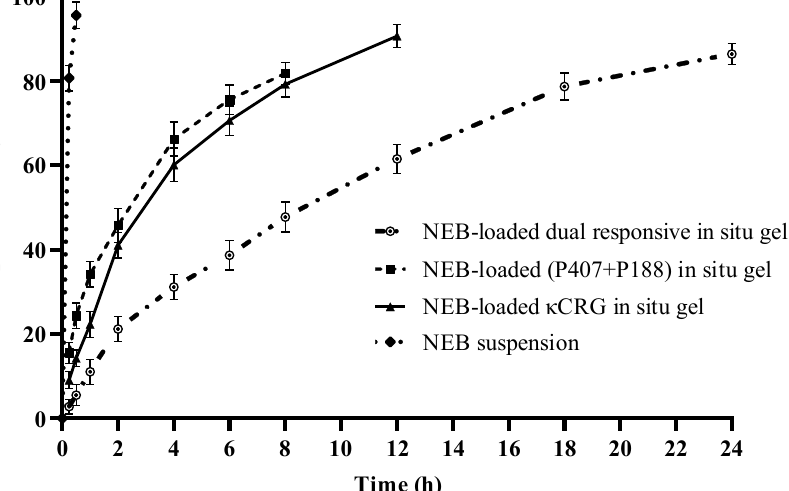
Figure 6. In vitro drug release profiles of an NEB suspension, NEB-loaded (P407 + P188) in situ gel, NEB-loaded κ CRG in situ gel and NEB-loaded dual-responsive in situ gel. Each data point is the mean cumulative percent of NEB released ( ± SD) of three independent formulations ( n = 3).